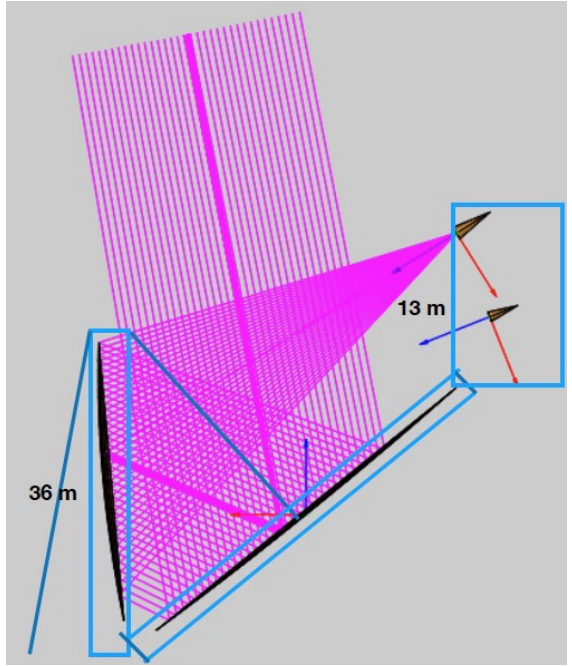
Figure 4. Optical design schematics as presented in the July 2019 CDR (Abdalla et al.